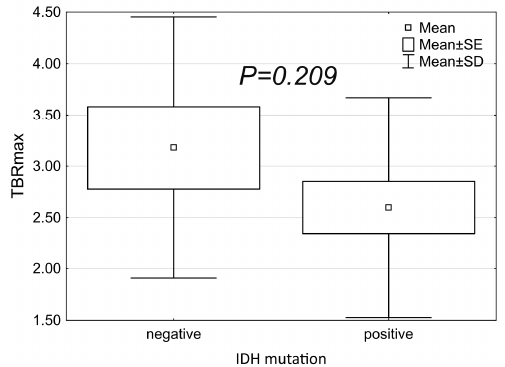
Figure 5. The association of SUVmax ( A ) and TBRmax ( B )with Ki-67 (Spearman’s rank order corre- lation).